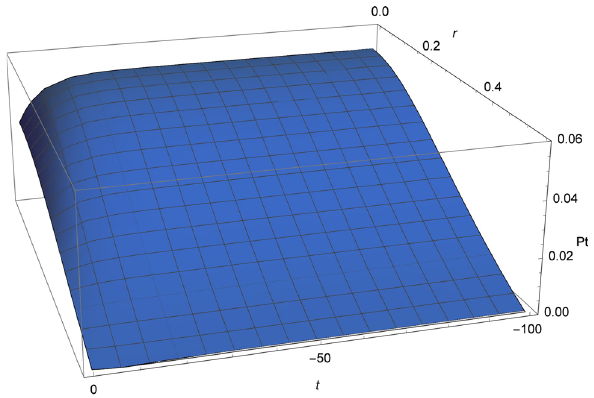
Fig. 3 Total tangential pressure, c 1 = 0 . 81, c 2 = 0 . 5, c 3 = − 10,